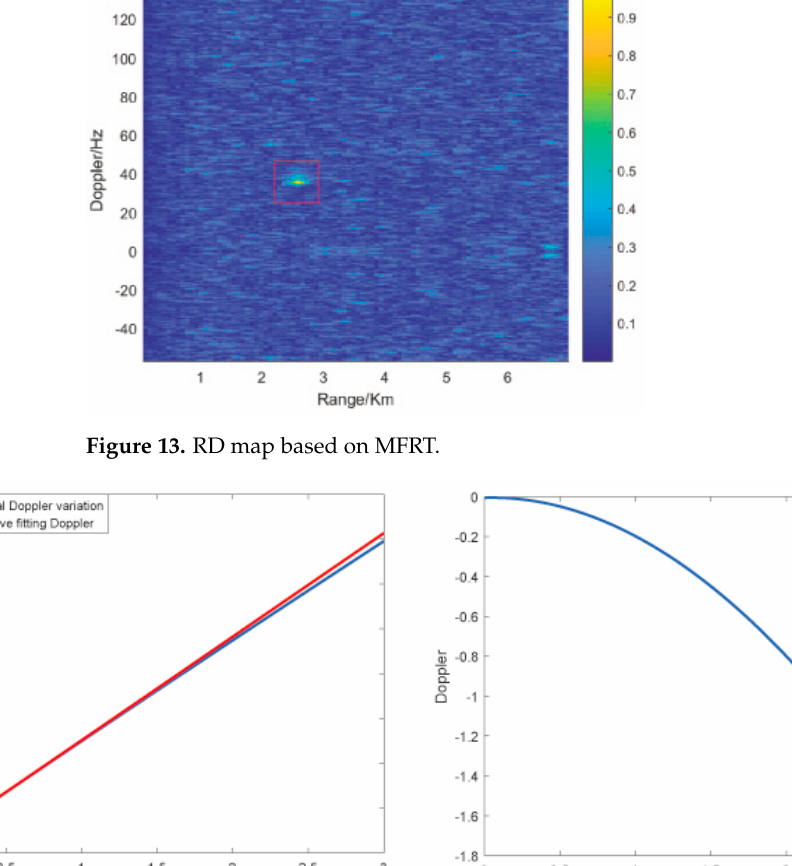
Figure 14. Doppler variation during the CPI. ( a ) Doppler variation and curve fitting result. ( b ) Curve fitting error.